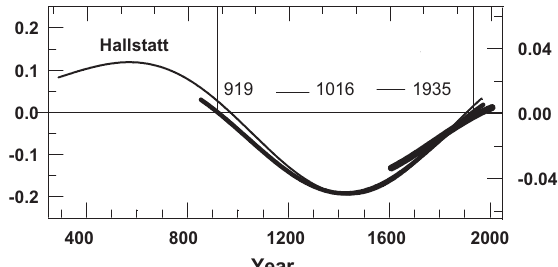
Fig. 9. The Hallstatt oscillation. We show three curves: from thickest to thinner: the international; sunspot number, the Schove (1955, 1961) and Usoskin et al.’s (2003) time series, all scaled to fit. The right-hand abscissa corresponds with the historical and Schove time series and the left-hand abscissa is that of Usoskin et al. (2003).